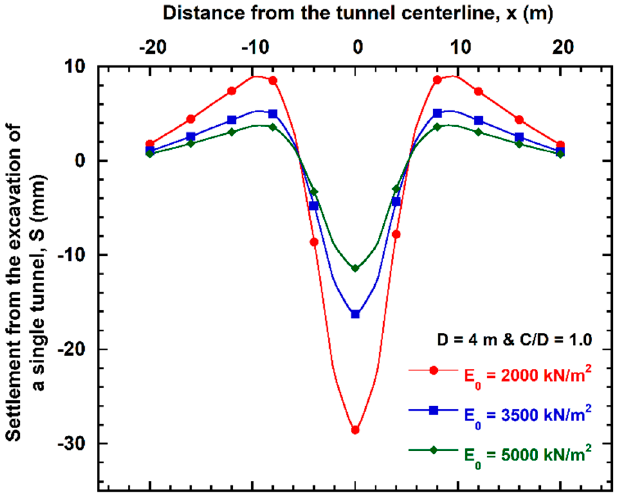
Figure 3. Effect of Young’s modulus of elasticity on tunnelling induced ground settlement (initial E 0 shown).